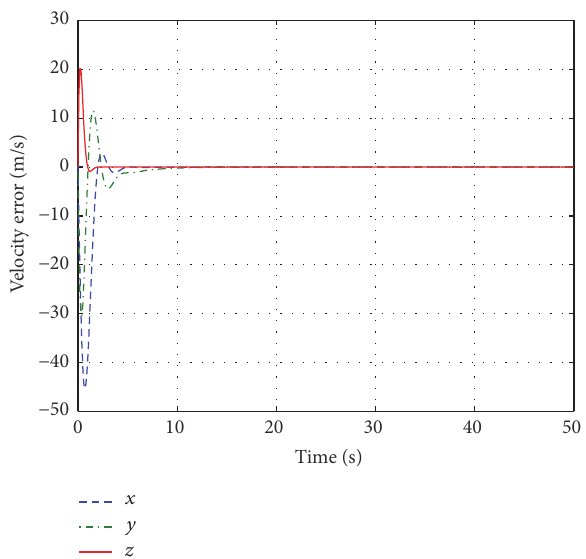
Figure 4: Velocity error variation curve of SDRE.